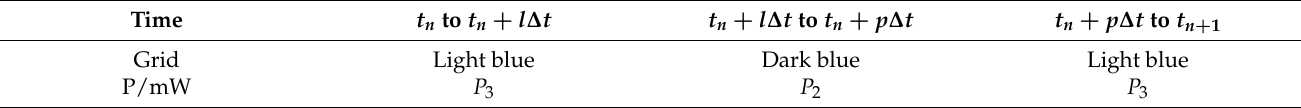
Table 3. Table of variation of cluster head transmitting